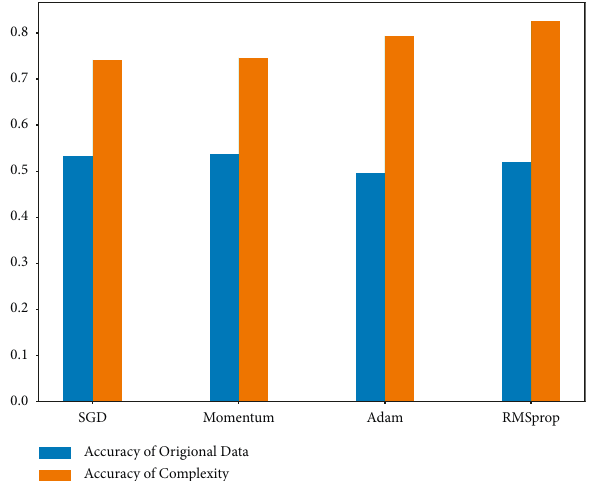
Figure 10: Accuracy achieved for different